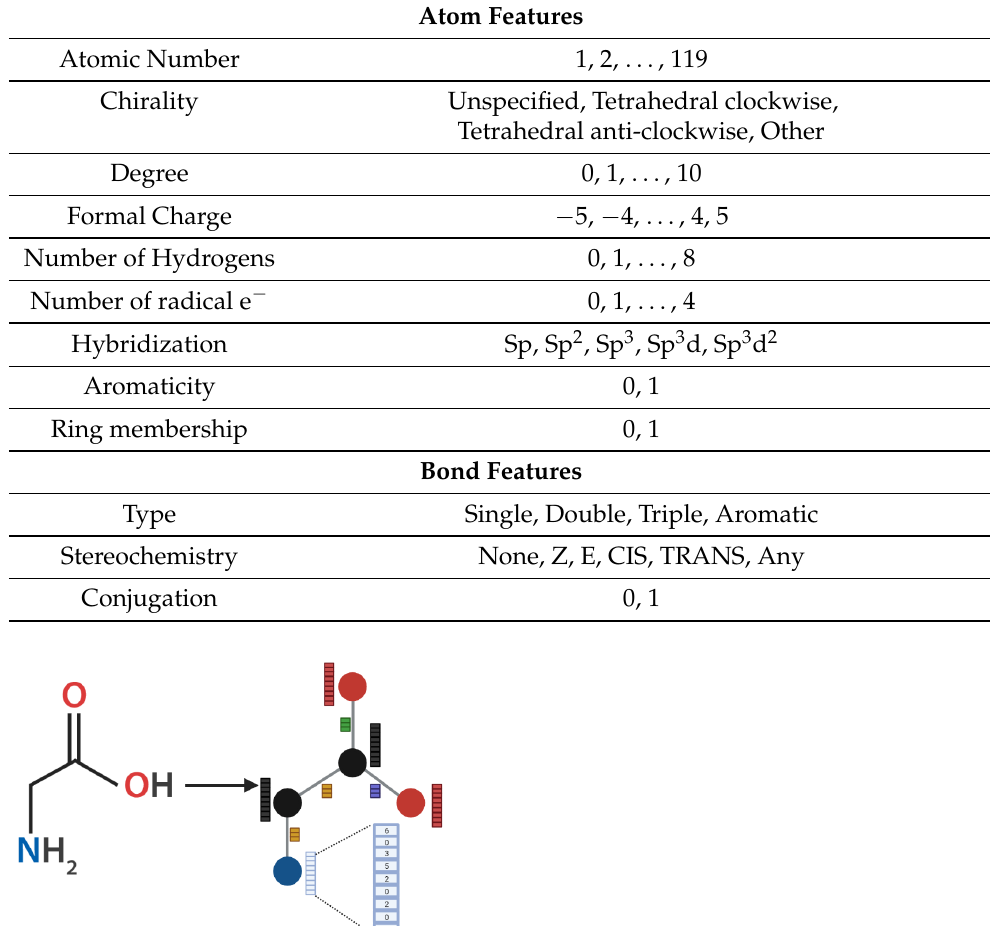
Figure 4. Graph Representation of Glycine. In the graph representation of molecules, atoms are represented as nodes and bonds as the edges. Each amino acid atom is represented within the graph by nine physicochemical properties (Table 3). Likewise, bonds between the atoms were described by three properties. The same color implies the same atom and/or bond and, therefore same feature vector. Created with